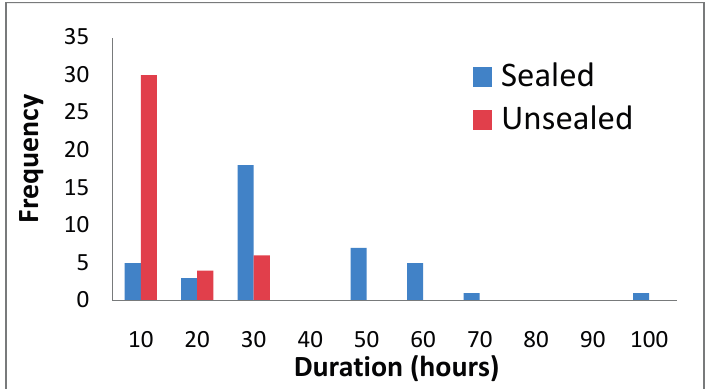
Figure 5. Histogram of the simulated duration in hours until no difference in soil moisture could be observed between the 0–2 and 0–10-cm soil depth layers.